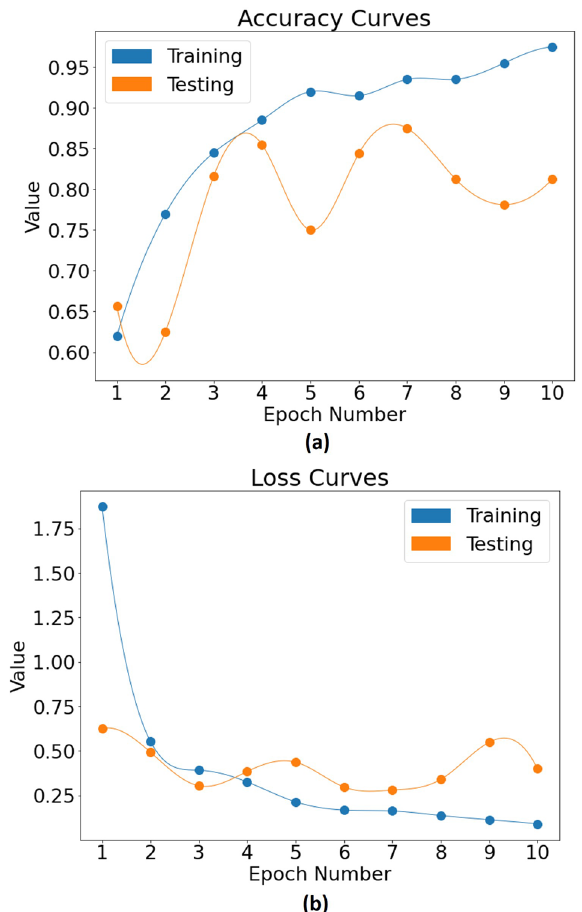
Figure 5. Performance curves of the CNN model for run #1 in terms of: ( a ) accuracy score, ranging between 0 and 1; ( b ) loss function values, ranging between 0 and the highest observable error (~ 2) for this specific run, both plotted against the number of epochs for the training (blue) and testing (orange) sets. Results are represented by circular symbols and the cubic spline curves are guides for the eye. The point of divergence between the training and testing curve in both ( a ) and ( b ) begins at the 7th epoch, making it the point of the optimal trained state of the CNN model, with a testing accuracy of 87.5% and training accuracy 93.5%. For details, see